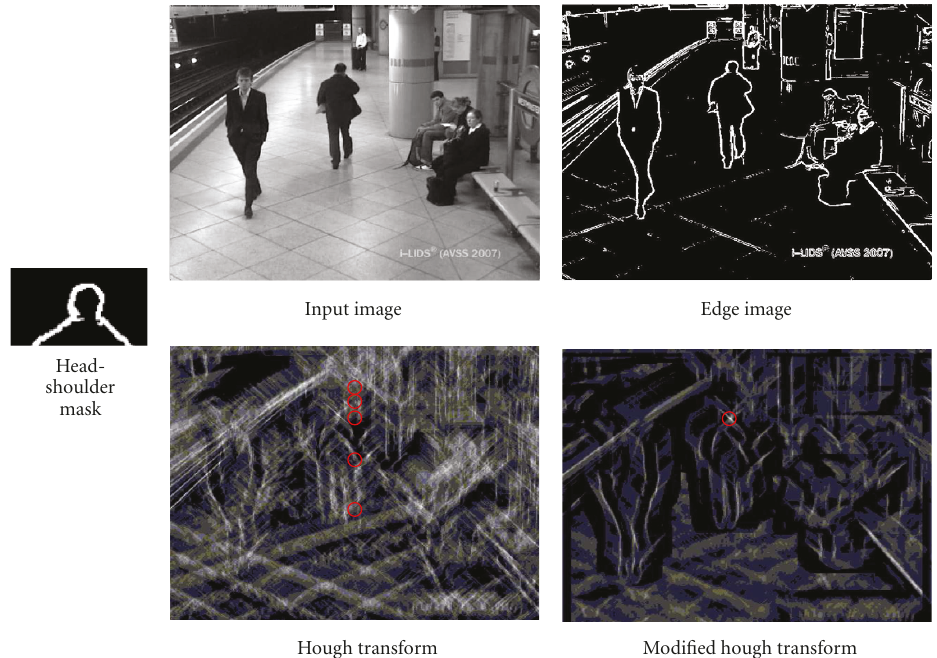
Figure 7: The leftmost image is the queried head-shoulder contour. Given the input image, the edge image is obtained via 3 × 3 Sobel convolution. Adopting traditional HT will generate a detection result giving more false positives. The improved HT method yields a single large response at the correct location of the most visible head-shoulder contour in the input edge